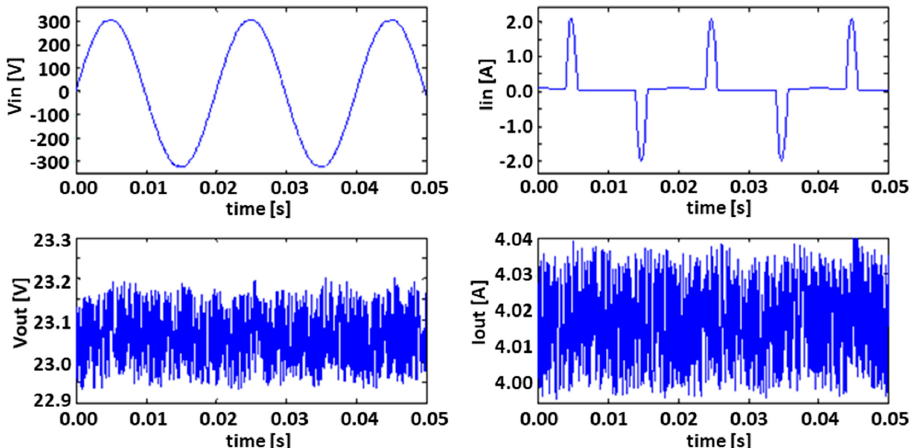
Figure 10. Time evolution of the AC and DC sides for the test condition #1.